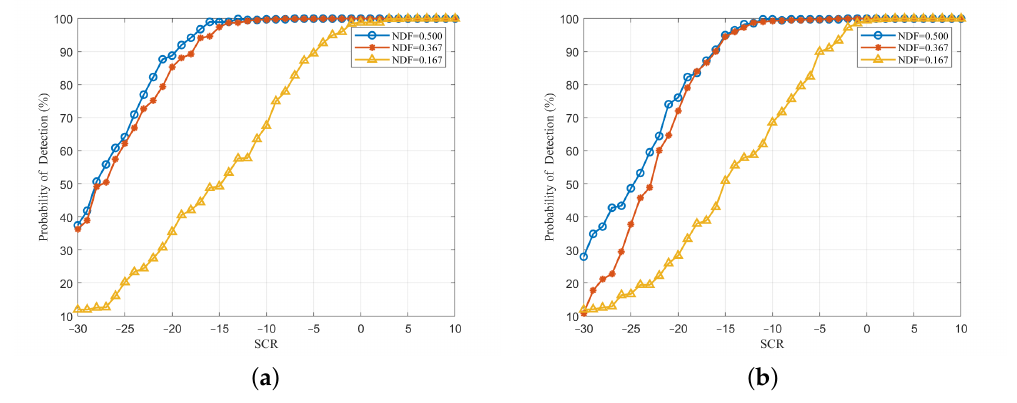
Figure 7. PD versus SCR curves of different NDFs. ( a ) ideal case; ( b ) non-ideal